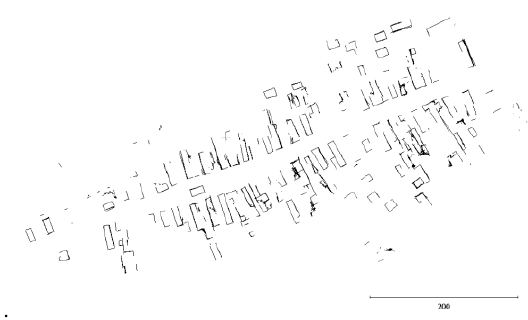
. Figure 11 . Detected walls at Barang test area.